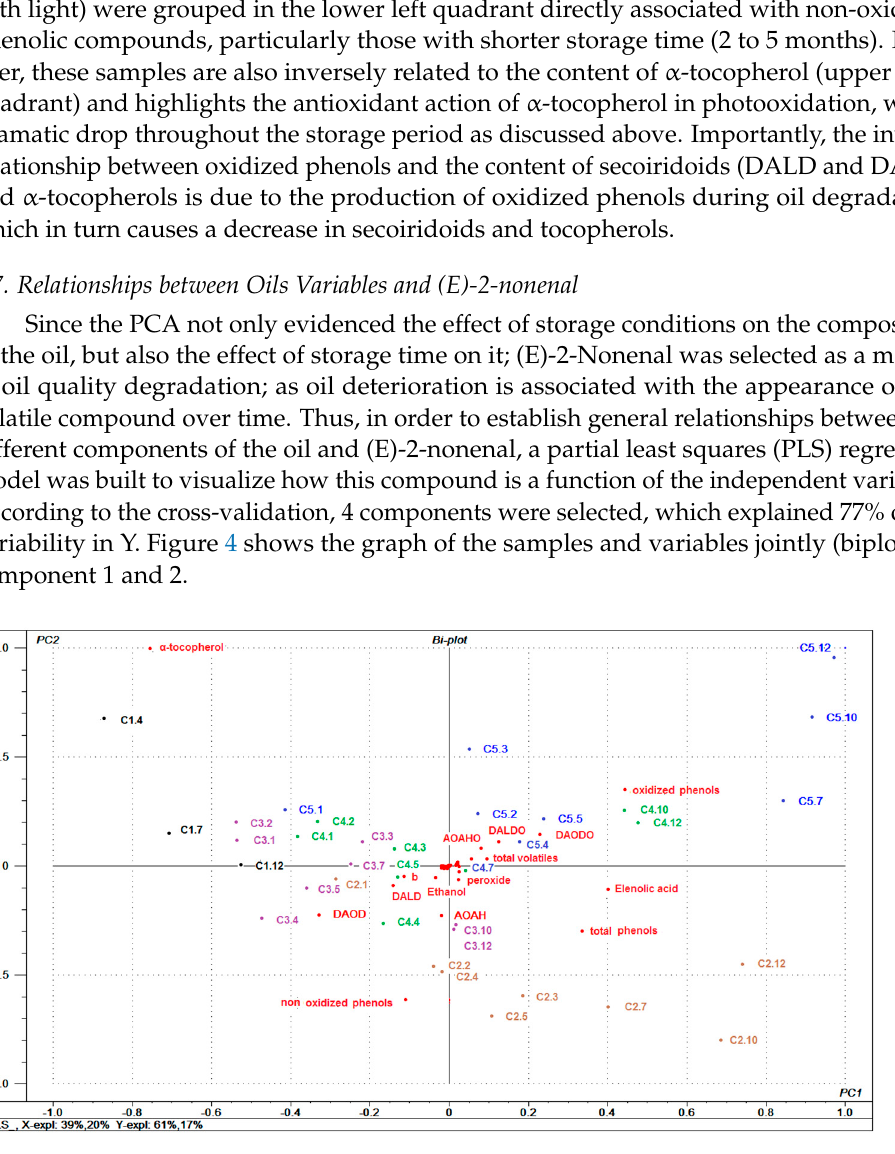
Figure 4. Relationships between oils variables and ( E )-2-nonenal by PLSA. Plots of samples and variables. Sample are labeled by storage conditions. Abbreviations see Figure 3.